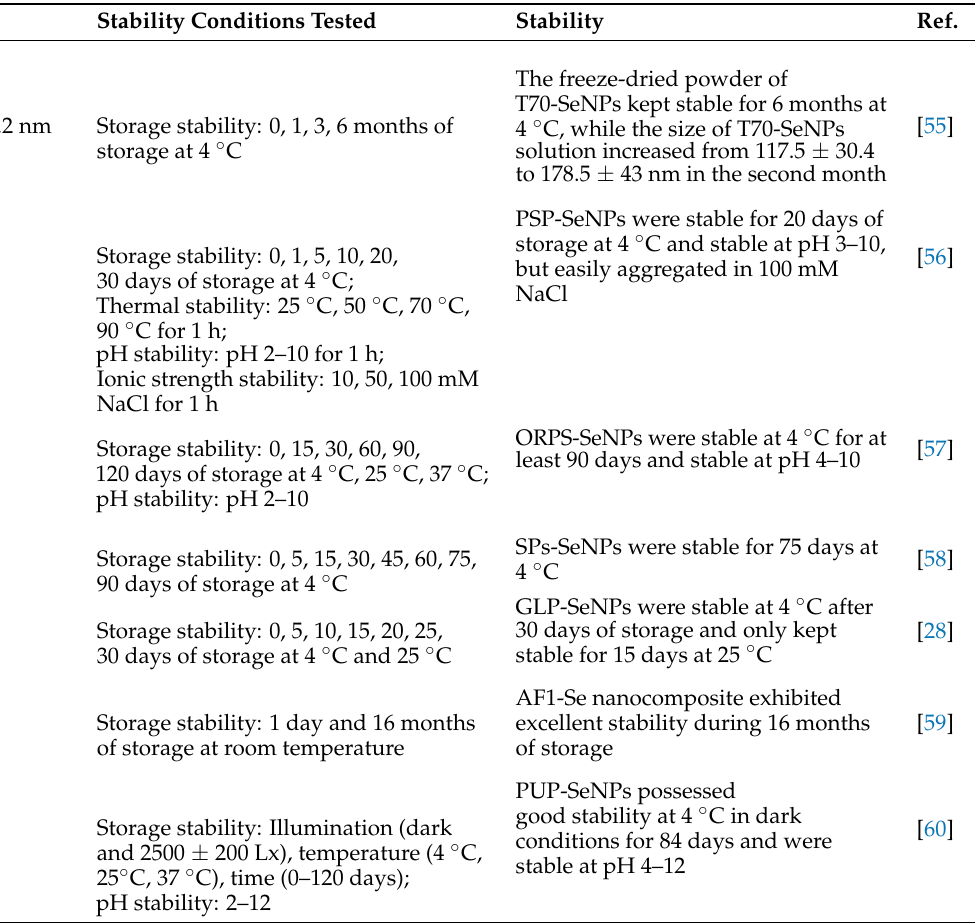
Table 1. The reaction conditions, size, stability conditions tested, and stability of various biomolecules functionalized